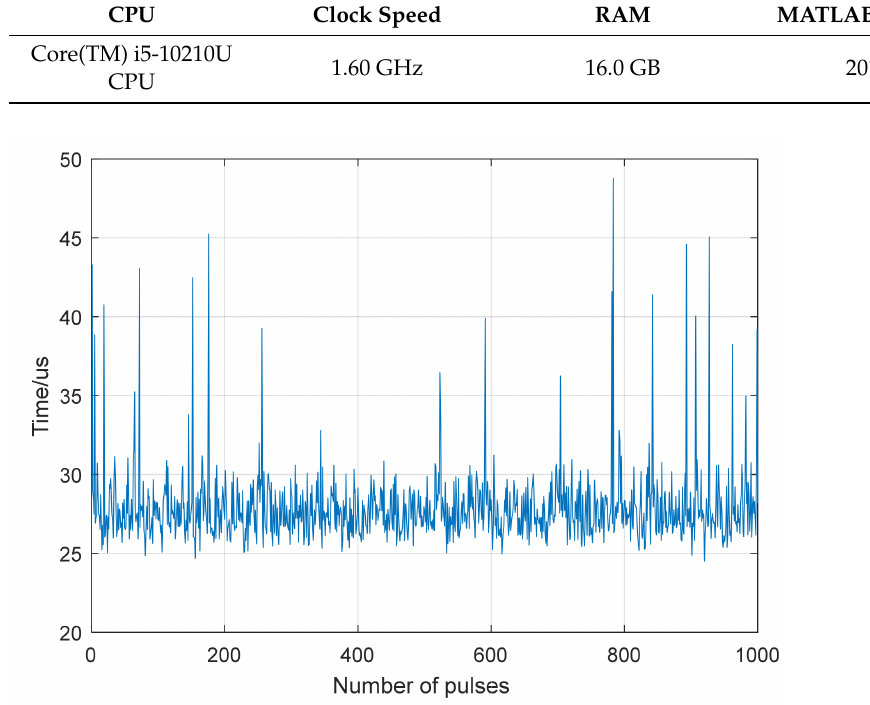
Table 2. Software configuration environment.